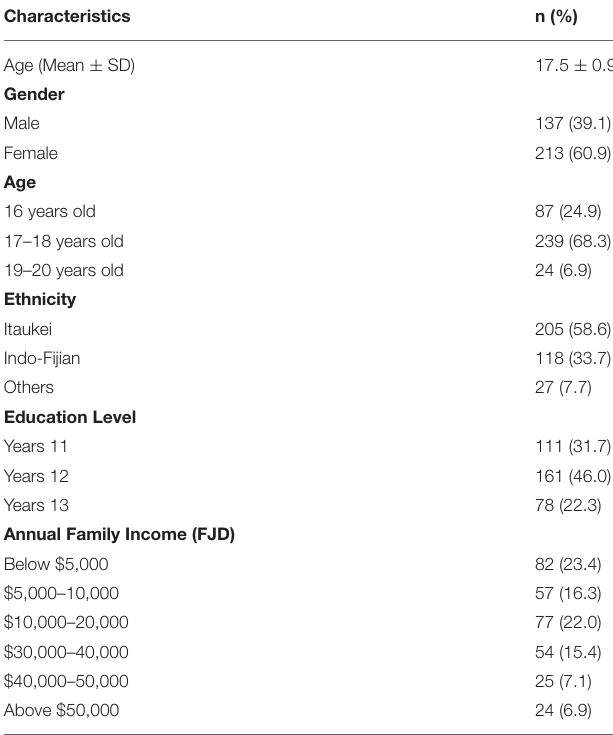
TABLE 1 | Socio-demographic characteristics of participants.